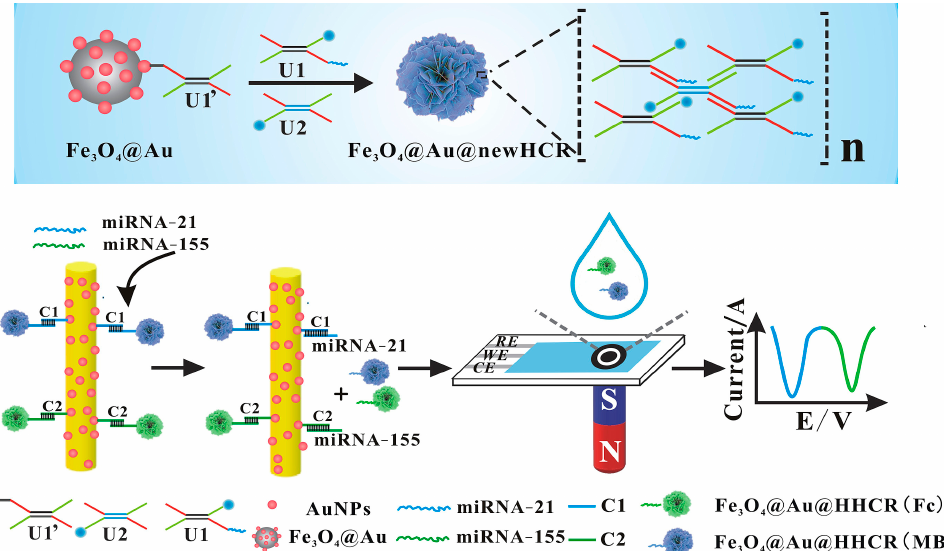
Figure 5. MNP ‐ based electrochemical biosensor platform for miRNA ‐ 21 and miRNA ‐ 155. [Repro ‐ Figure 5. MNP-based electrochemical biosensor platform for miRNA-21 and miRNA-155. [Repro- duced with the permission of [197] Copyright 2019 Published by Elsevier B.V.]. duced with the permission of [197] Copyright 2019 Published by Elsevier